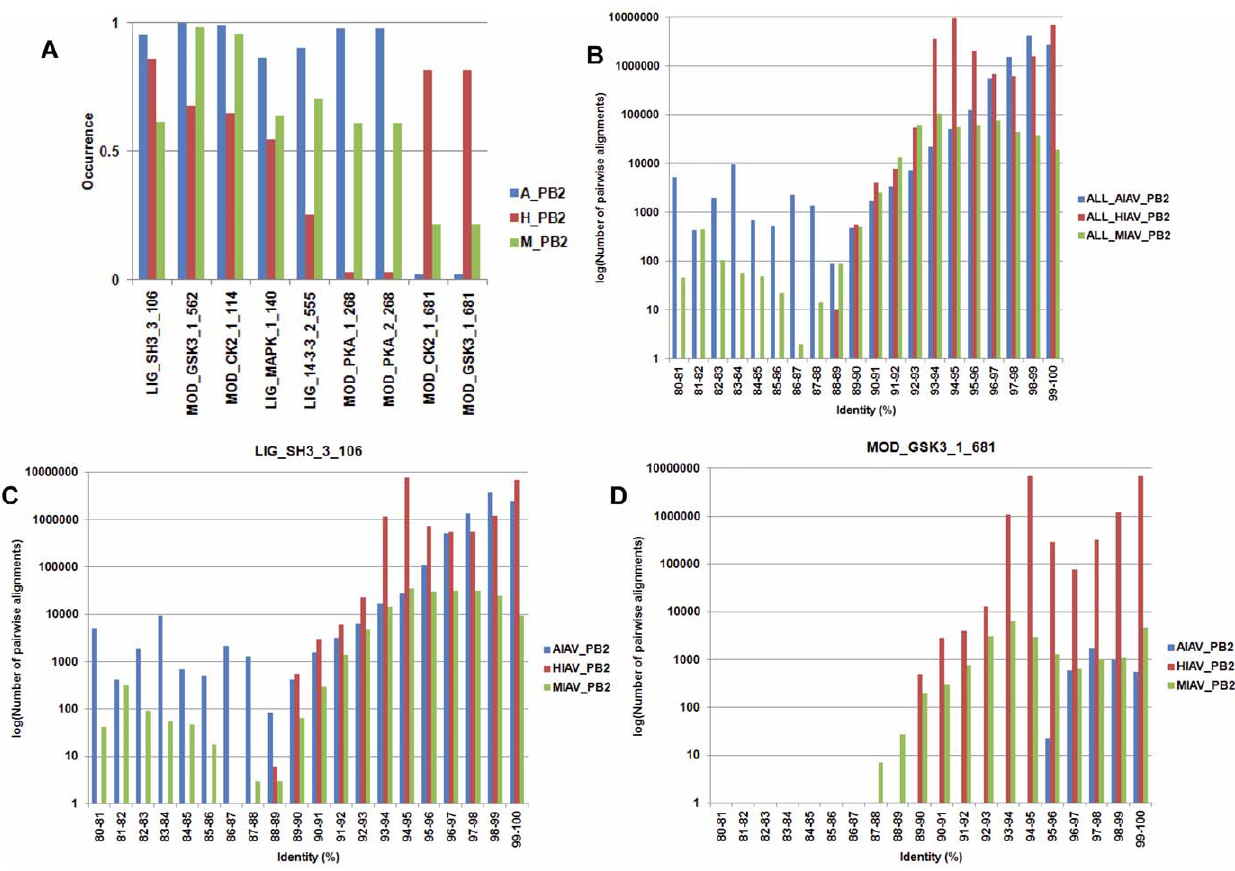
Figure 4. SLiMs from IAV PB2 proteins that have a differential occurrence in IAVs from different hosts. (A) 9 SLiMs that have a differential occurrence in IAV PB2 proteins from different hosts. A_PB2, H_PB2 and M_PB2 indicate the PB2 proteins from avian, human and IAV, respectively. The Y-axis indicates the occurrence of each identified SLiM. The X-axis indicates the name and position of each identified SLiM in the PB1 proteins. For example, ‘‘LIG_SH3_3’’ in ‘‘LIG_SH3_3_106’’ is the name of the SLiM, and 106 is the amino acid position where the SLiM starts. (B) The distribution of pairwise alignment identity of all PB2 protein sequences from avian, human and mammalian IAVs. (C) The distribution of pairwise alignment identity of PB2 protein sequences which harbor the SLiM LIG_SH3_3_106 from avian, human and mammalian IAVs. (D) The distribution of pairwise alignment identity of PB2 protein sequences which harbor the SLiM MOD_GSK3_1_681 from avian, human and mammalian IAVs. For B, C and D, the X-axis indicates the number of pairwise alignments of IAV PB2 protein sequences. The Y-axis indicates the identity of pairwise alignment (the percentage of identical amino acids that are the same in both PB2 sequences). Blue: PB2 protein sequences from avian IAVs. Red: PB2 protein sequences from human IAVs. Green: PB2 protein sequences from mammalian